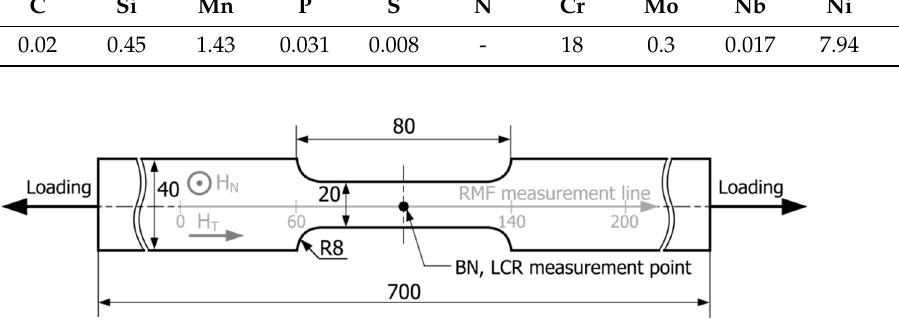
Figure 1. Tested specimen geometry with marked measuring points (RMF—residual magnetic field, H N —normal component of the RMF, H T —tangential component of the RMF, LCR—impedance components of the LCR measuring circuit, BN—Barkhausen noise).